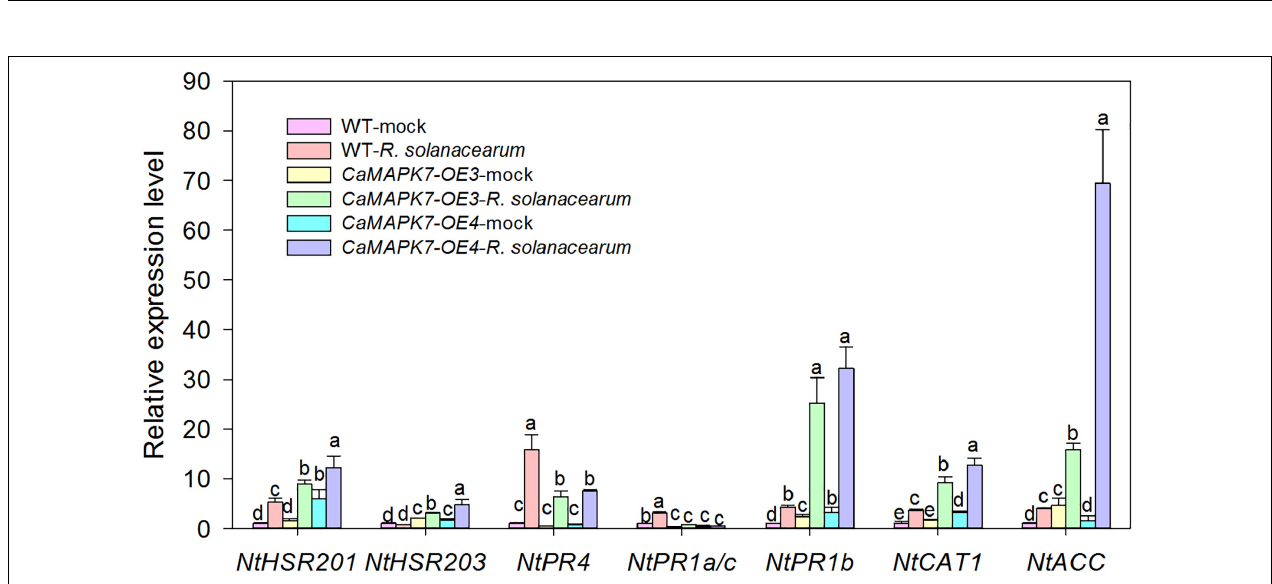
FIGURE 7 | qRT-PCR analyses of relative expression levels of defense marker genes in CaMAPK7-OX lines compared with WT tobacco plants. Defense-related transcript accumulation of WT tobacco plants were used as reference, which was set to “1.” Different letters above the bar show a significant difference between the means of the three biological replicates based on Fisher’s protected LSD test: lowercase letters, p < 0.05. WT, wild-type.